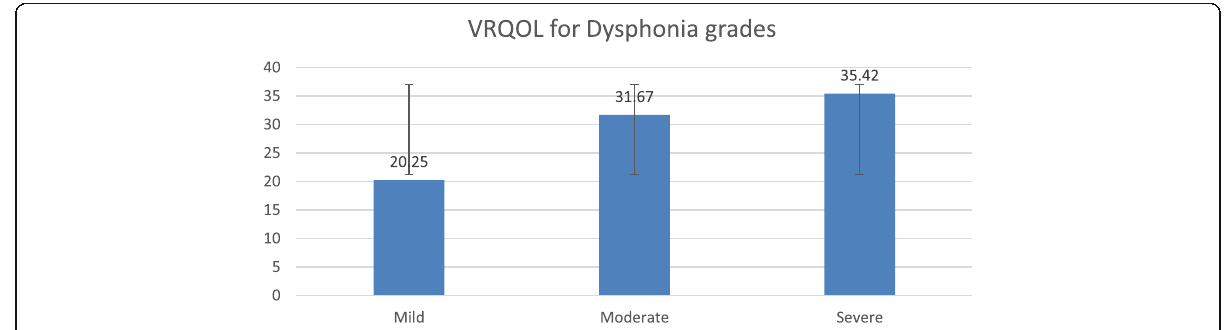
Fig. 2 Comparison of different dysphonia grades (modified GRBAS) by mean total V-RQOL scores among dysphonic